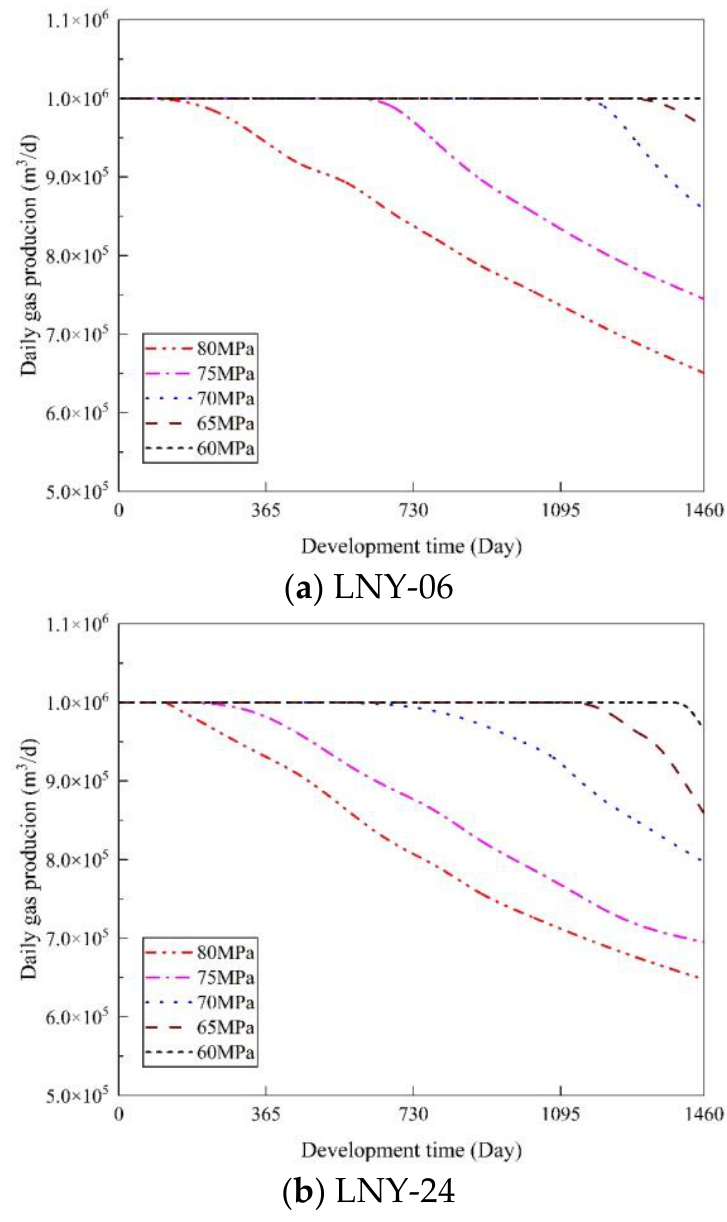
Figure 21. Variation of gas production at different bottom hole pressures.